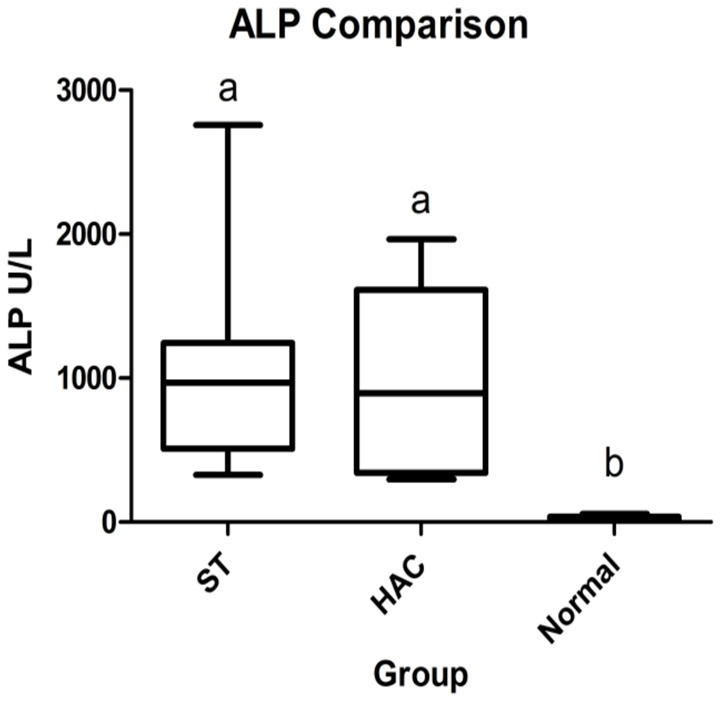
Box and whisker plots of serum alkaline phosphatase (ALP) data between dogs in the Scottish terrier (ST), hyperadrenocorticism (HAC), and control (Normal) groups; whiskers min to max, box Q1-Q3, bar represents median value, groups with differing lowercase letter superscripts are significantly different (p < 0.05).